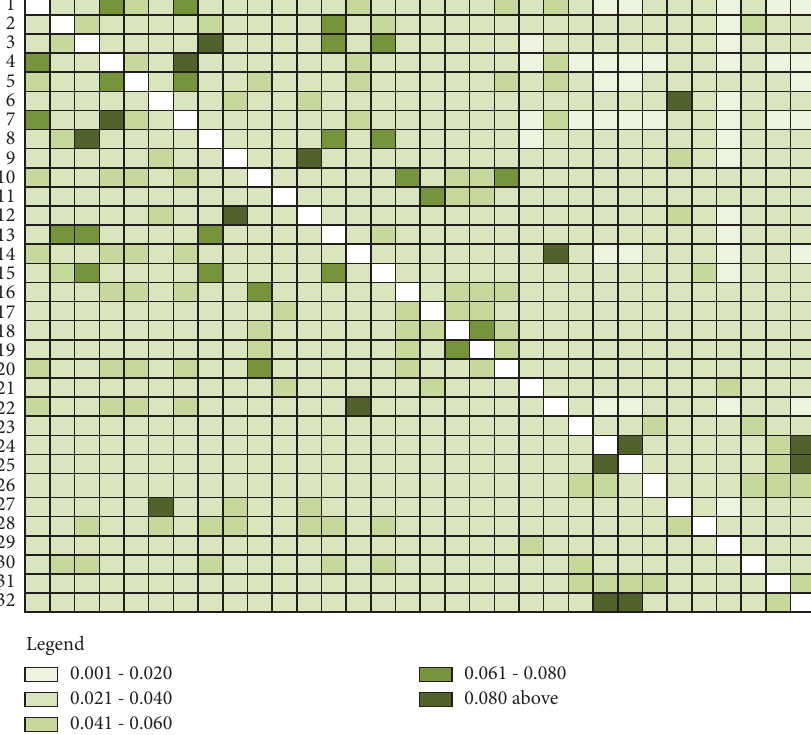
Figure 12: Weight element categorization in